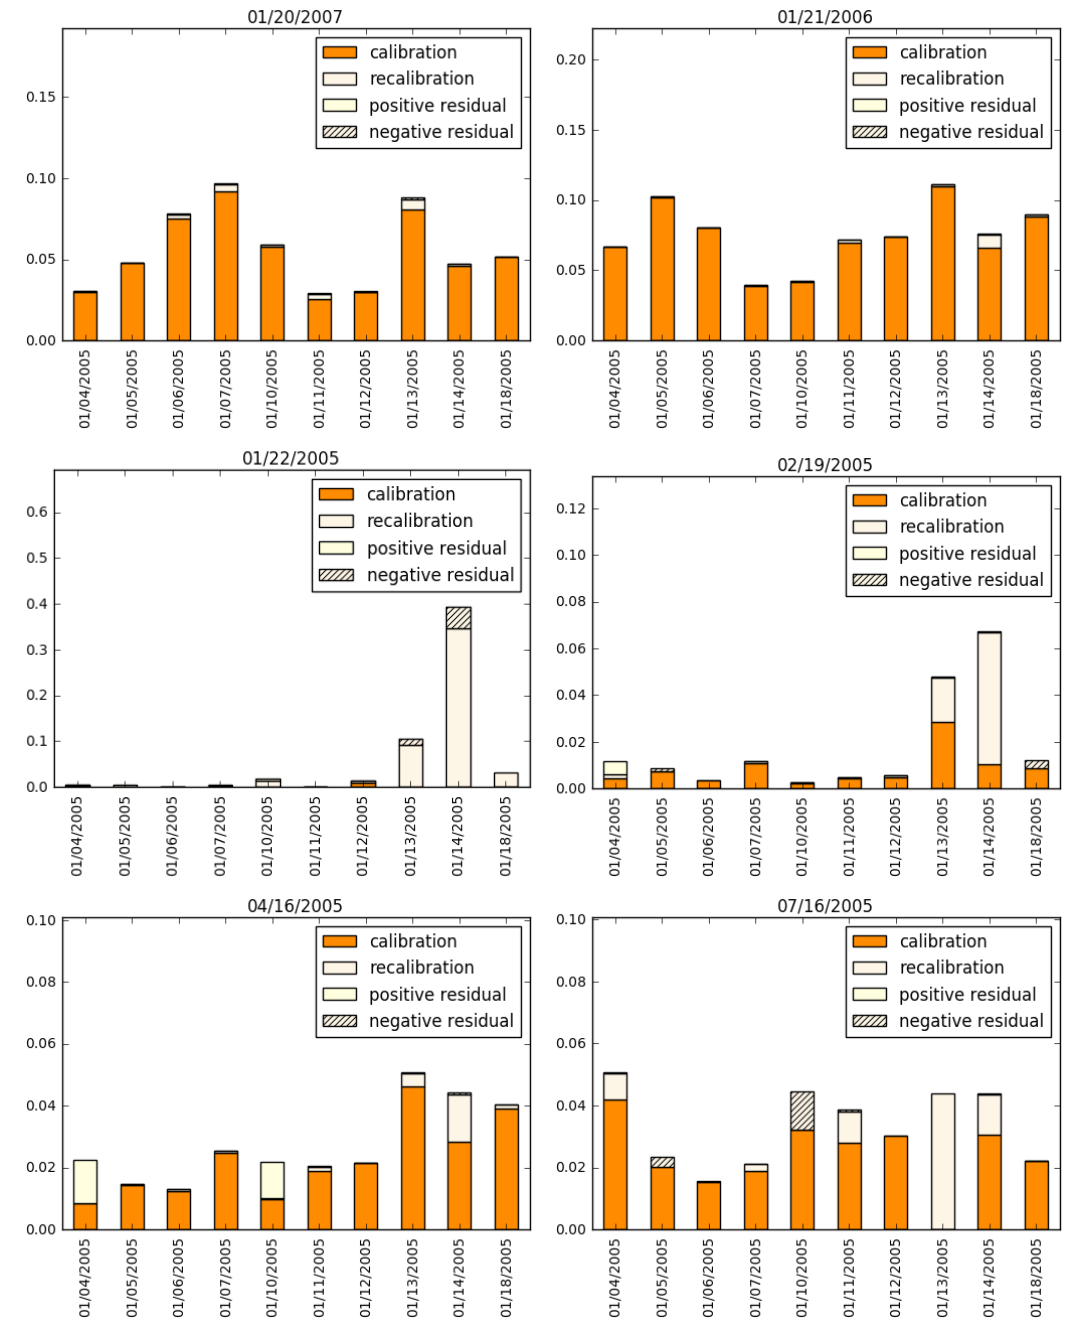
Figure 2. Decomposition of model risks of Apple (AAPL) options while using the Black/Scholes model as the nominal model, for a selection of option maturity dates (given as the title of each graph). The vertical axis denotes the numerical value of the relative